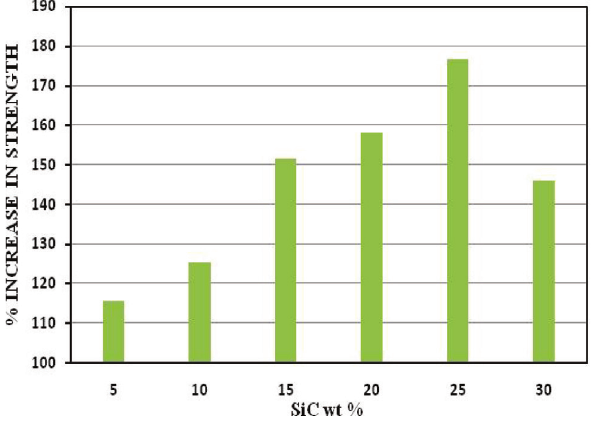
Fig. 5: % increase in ultimate strength of various composites from base Al metal